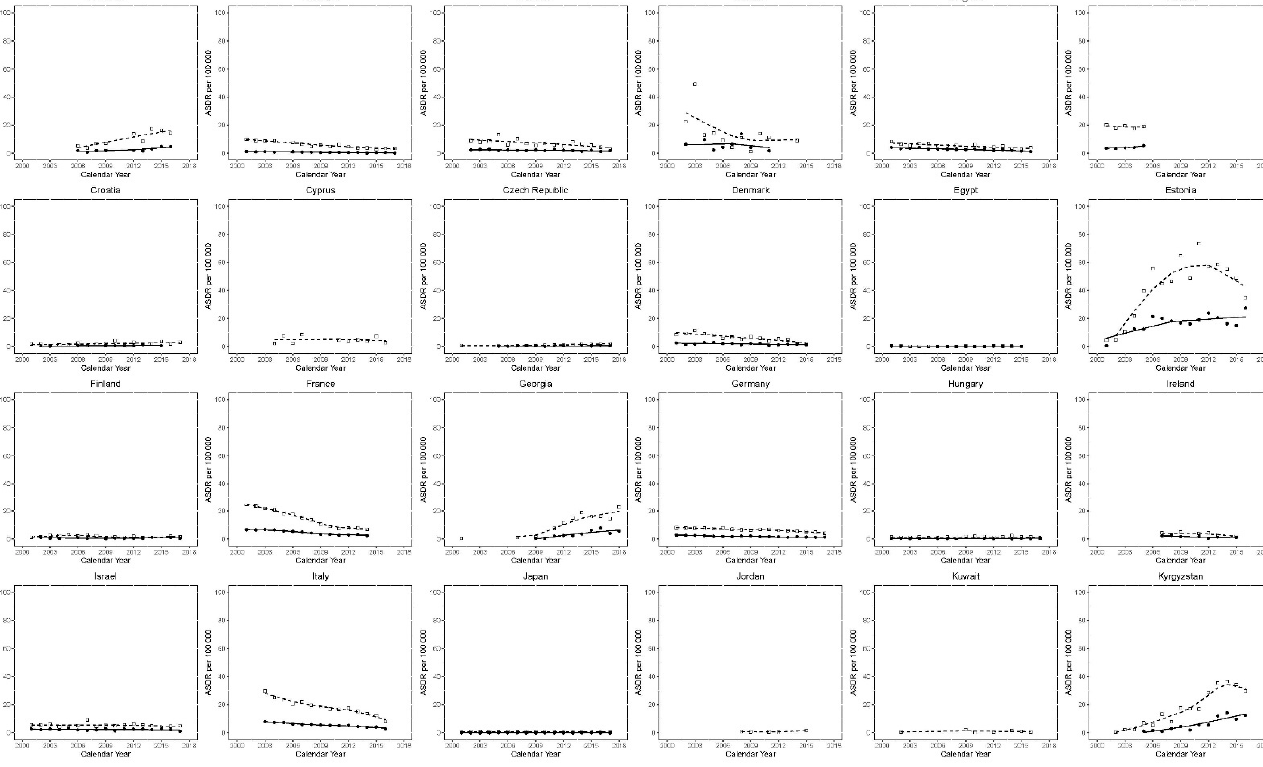
Figure 1. Trends in age-standardized death certification rates per 100,000 for HIV. Squares indicate male mortality, whereas circles indicate females.